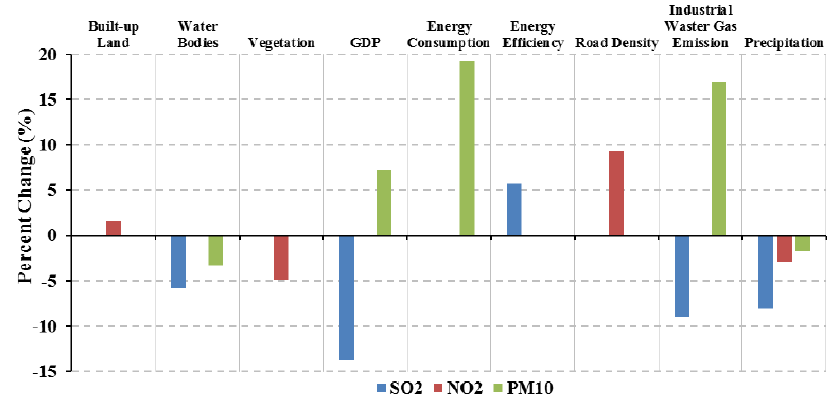
Figure 6. Percent change in air pollutant concentrations associated with every one standard deviation increase from mean value of each independent variable while all other independent variables are held at mean value.